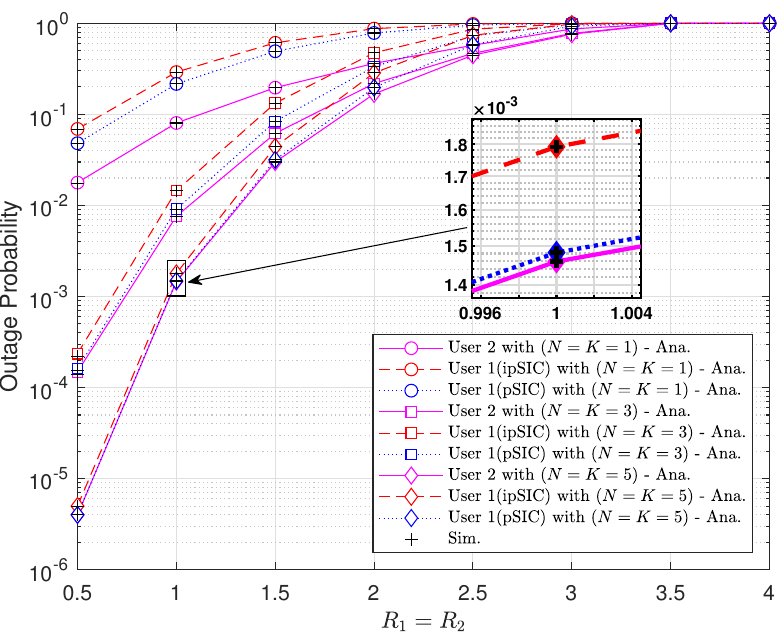
Figure 7. Outage probabilities versus target data rates with a 1 = 0.9, a 2 = 0.1, m = 2, and ρ = 5 [dB].